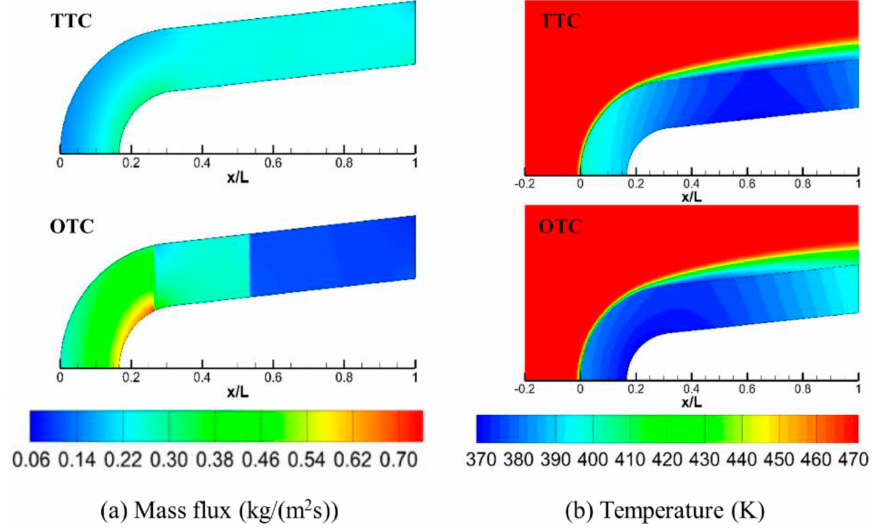
Figure 36. Coolant mass flux within TTC and OTC specimens and the corresponding temperature contour at injection ratio of 1.00%. Adapted with permission from [131]. Copyright 2018 Elsevier.